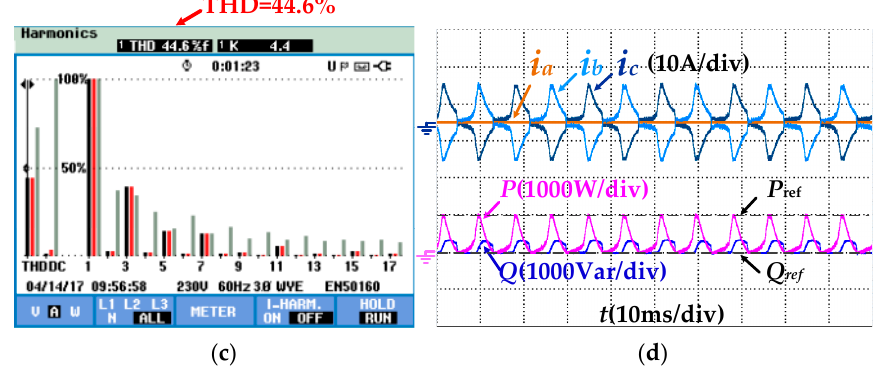
Figure 12. Experimental results of traditional MPDPC in inverter mode with leg faults of phase a ( a ) negative current unbalance; ( b ) voltage waveform; ( c ) harmonics spectrum; ( d ) current and power waveform.